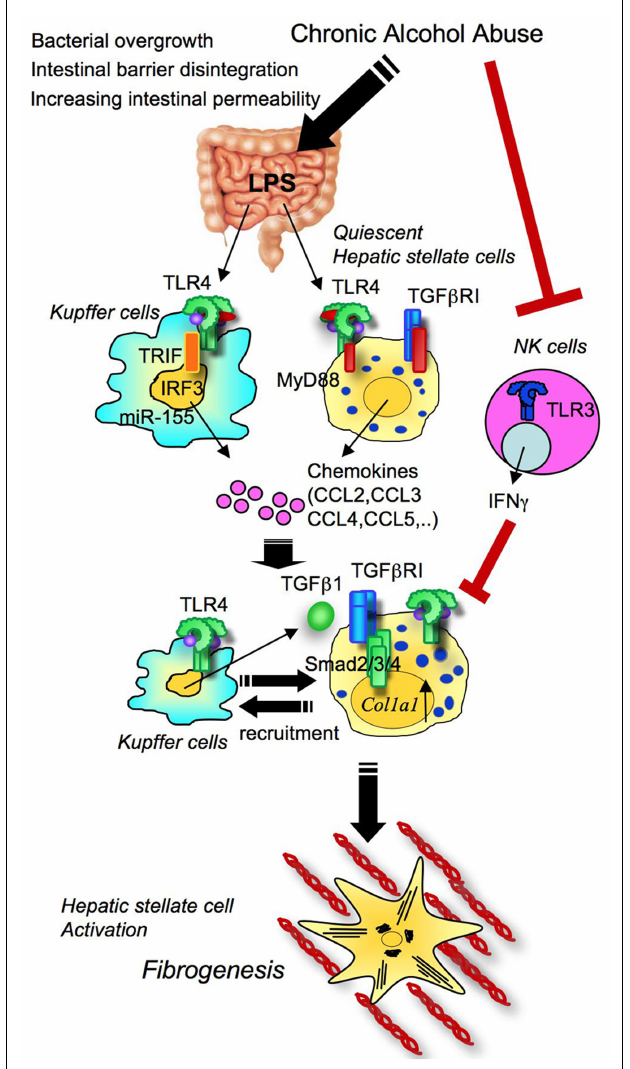
FIGURE 7 |TLR4 signaling in alcoholic steatohepatitis and fibrosis. Excessive alcohol abuse induces changes in the composition of intestinal microbiota and bacterial overgrowth.With tight junction disintegrity, intestinal permeability increases, causing the translocation of gut microflora-derived LPS into the liver through the portal vein.Translocated LPS activatesTLR4 on both Kupffer cells and HSCs.TLR4 signaling induces the production of chemokines that promote migration of Kupffer cells and HSCs.TheTLR4–TRIF–IRF3 pathway and miR-155 controlTLR4 activation in Kupffer cells.These events induce liver inflammation, hepatocyte steatosis, and